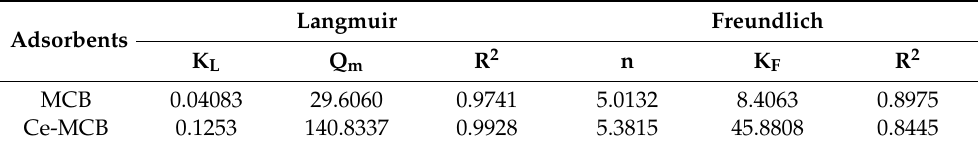
Table 5. The fitting parameters of absorption kinetics. Adsorbents